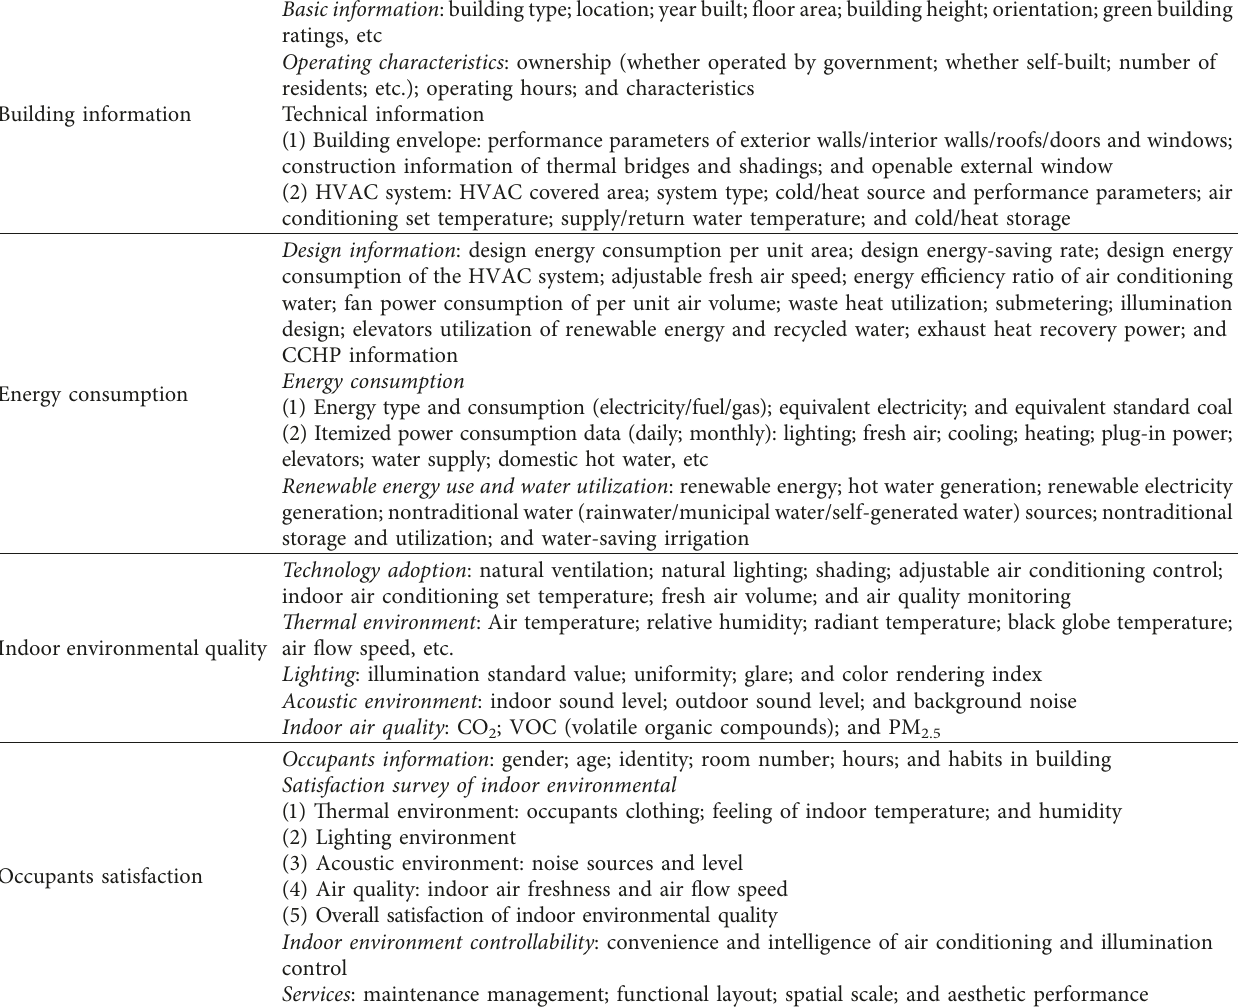
Table 3: Green building performance data